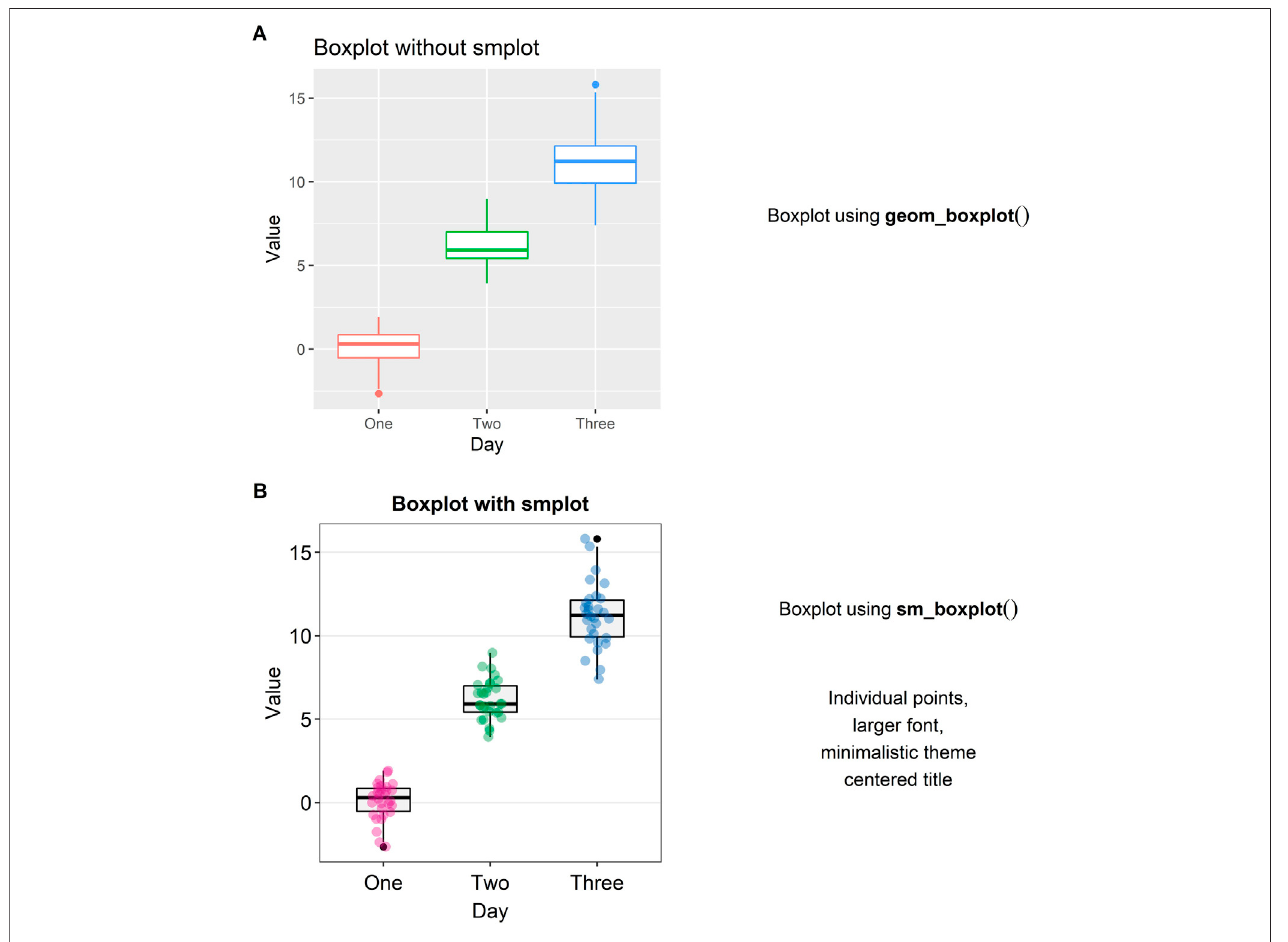
FIGURE3| Boxplotswithandwithout smplot . (A) Aboxplotdrawnwith “ geom_boxplot() ” ,whichisafunctionof ggplot2 . (B) Aboxplotdrawnwith “ sm_boxplot() ” . This function automatically provides several features, such as individual data points, larger font, minimalistic theme, and centered title.